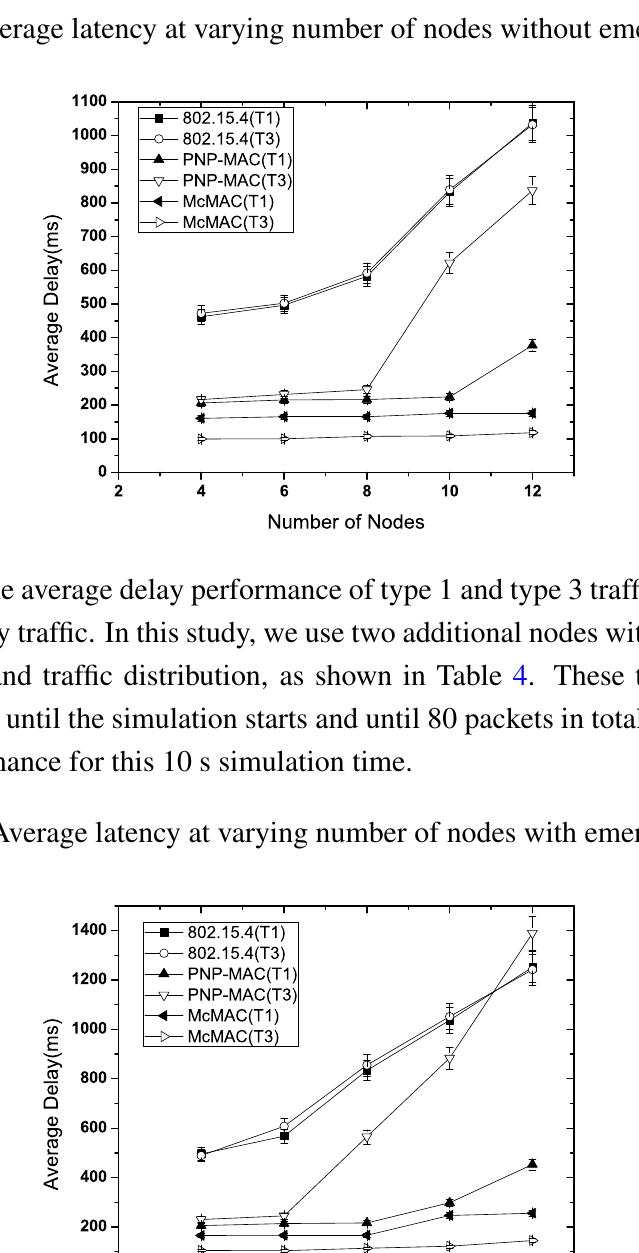
Figure 6. Average latency at varying number of nodes without emergency traffic.